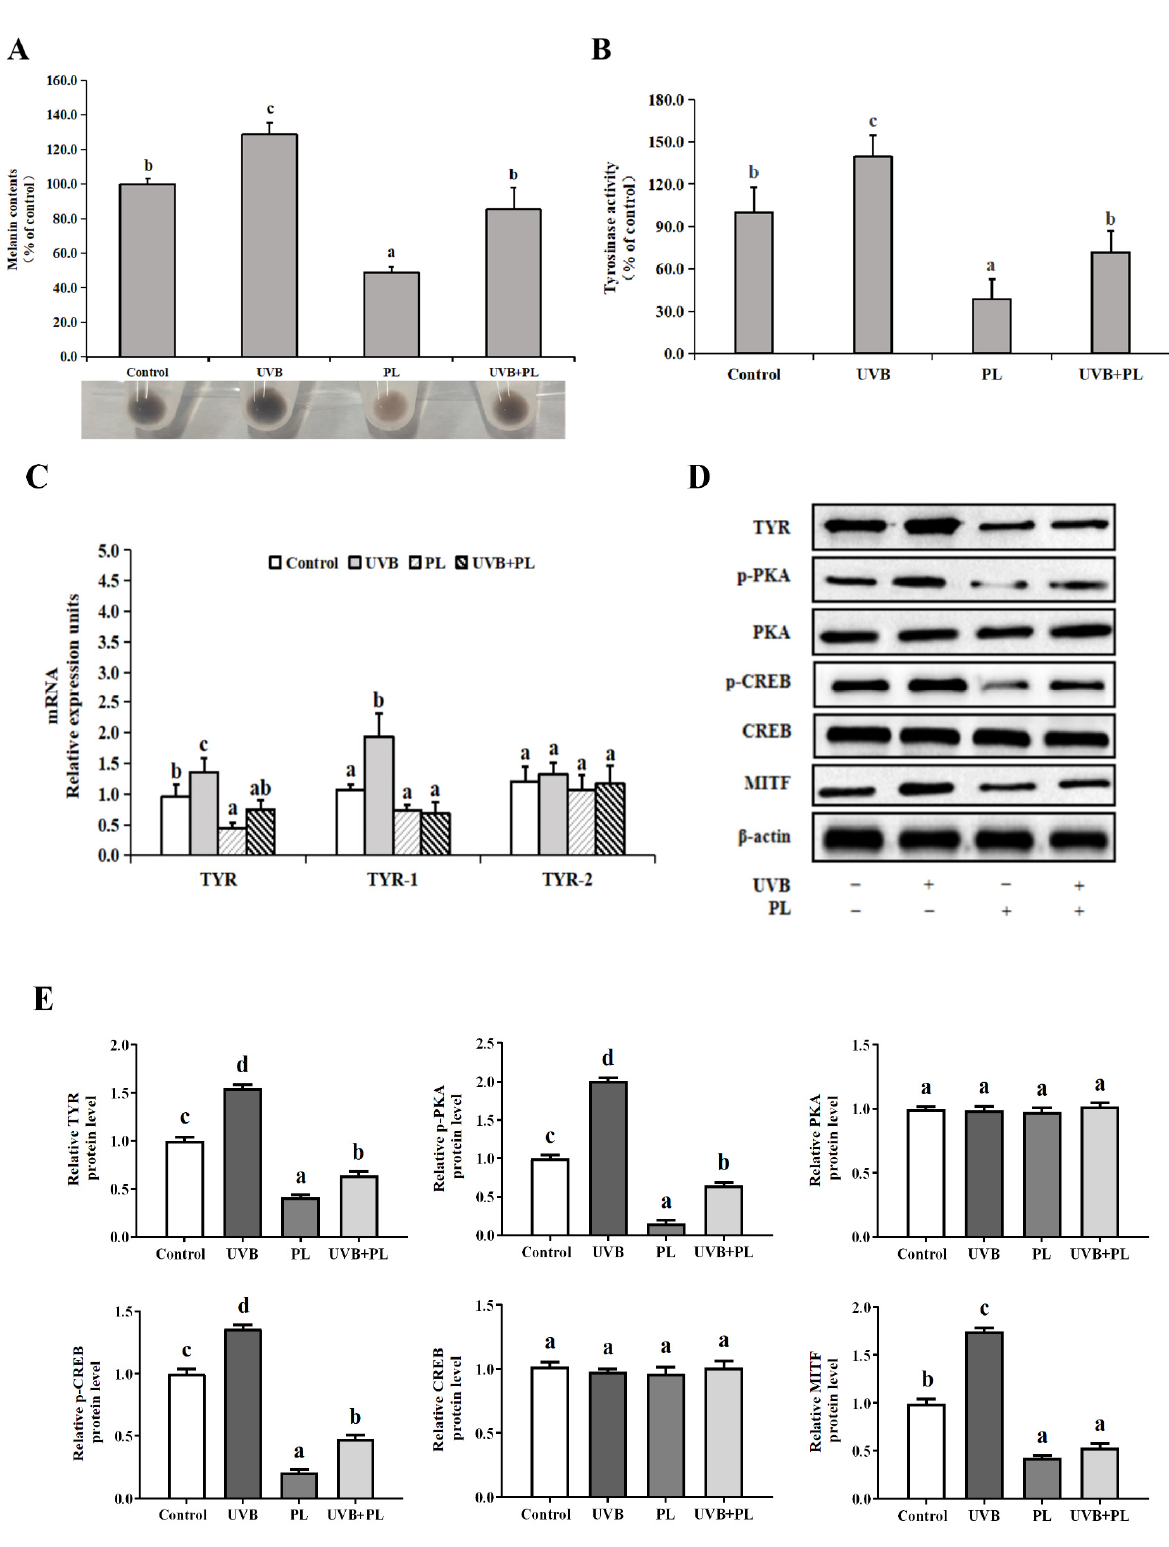
Figure 6. Effects of PL on melanogenesis-related parameters in B16F10 cells: ( A ) melanin content; ( B ) Tyrosinase activity; ( C ) The relative mRNA levels of TYRs; ( D , E ) The relative protein levels of TYR, p-PKA, PKA, p-CREB, CREB and MITF. Results are expressed as the mean ± SD ( n = 3). Differences among the variables were assessed using Duncan’s multiple range tests. Values having different letters are significantly different ( p < 0.05).